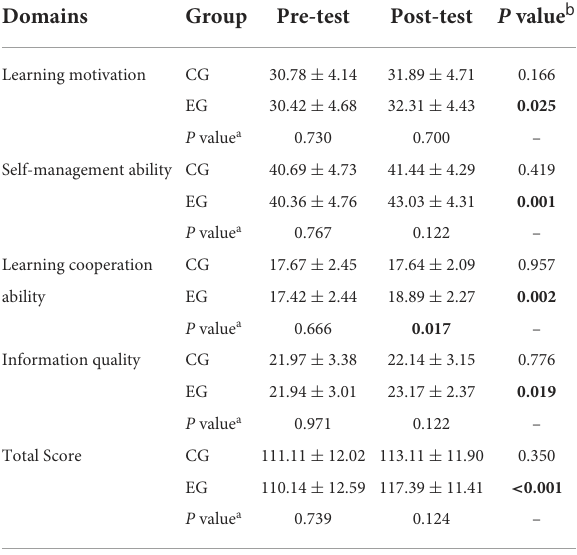
TABLE 4 Comparisons of self-learning ability in pre- and post-test and between two groups (M ± SD). Domains